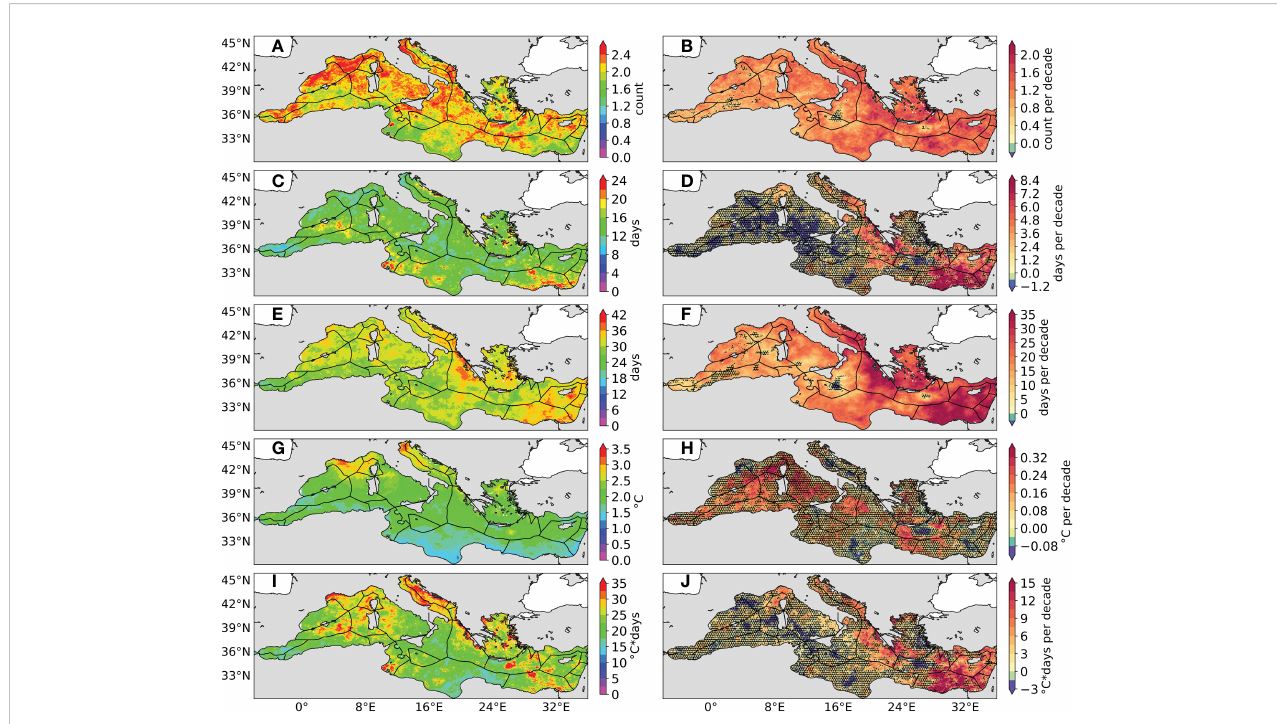
FIGURE 7 Means (Left panels, A, C, E, G, I ) and linear trends (Right panels, B, D, F, H, J ) from SST provided by MEDREA over the period 1987-2019 of annual MHW frequency ( A, B, in count), duration ( C, D, in days), total days ( E, F, in days), maximum intensity ( G, H, in °C) and cumulative intensity ( I, J , in °C*days). The black line indicates the bathymetry. Black hatches indicate where trend values are not signi fi cant at the 95% con fi dence level based on a Mann-Kendall trend